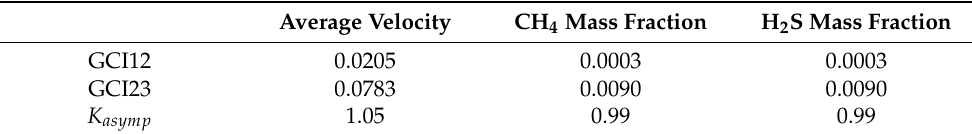
Table A1. Grid Convergence Index values for the SB simulation.